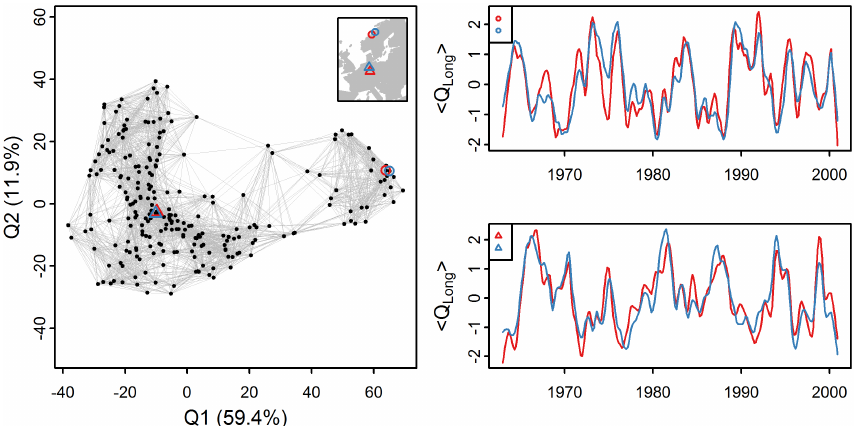
Fig. 6. Left panel: the space spanned by the two leading ISOMAP components derived from Q Long . The grey lines are the neighbourhood graph used to estimate the geodesic distances. Two pairs of neighbouring points are marked (triangles and circles) and their spatial location is indicated on the map. Right panel: time series of Q Long for the two pairs of points marked in the left panel ( <Q Long > denotes standardised low-frequency components of